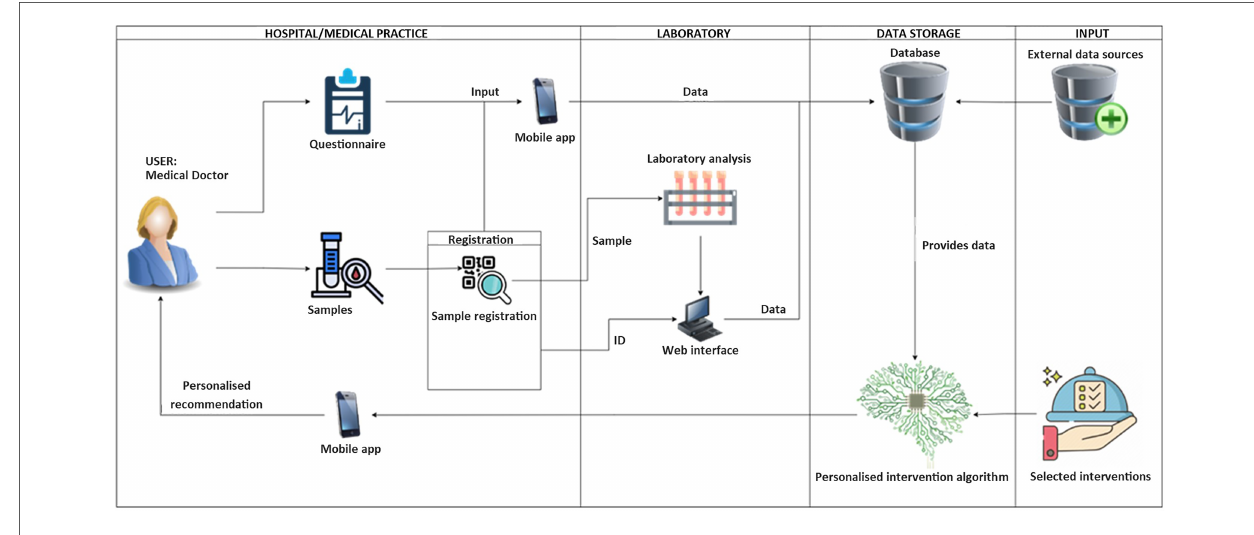
FIGURE 3 Data fl ow and functionalities of the Clinical Trial App